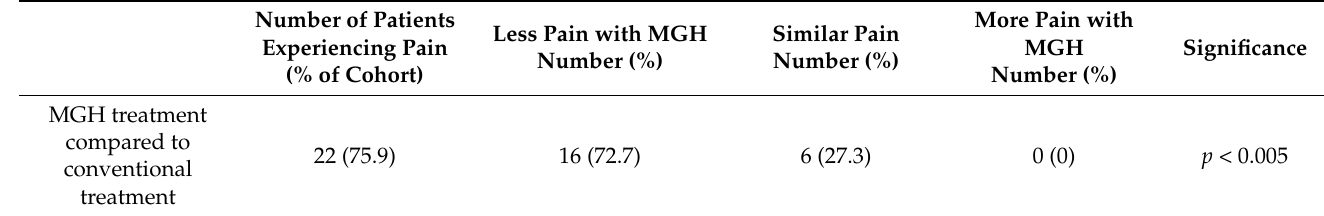
Table 2. Effect treatment on the experience of pain.